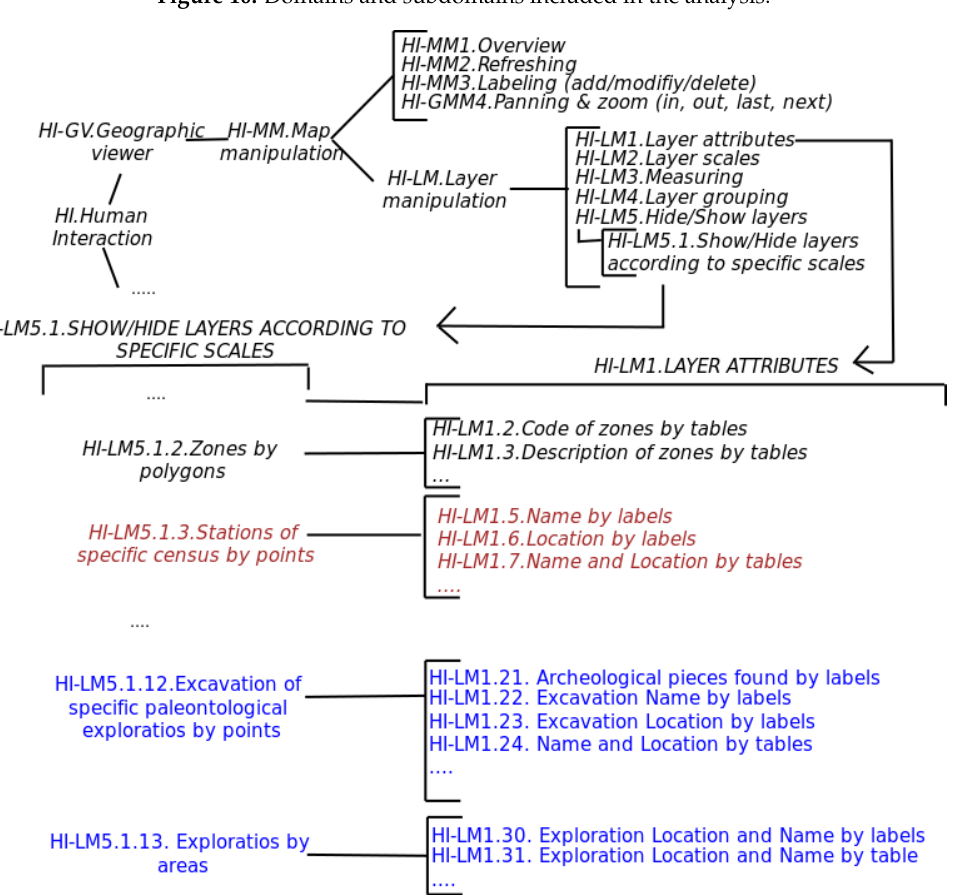
Figure 10. Domains and subdomains included in the analysis.